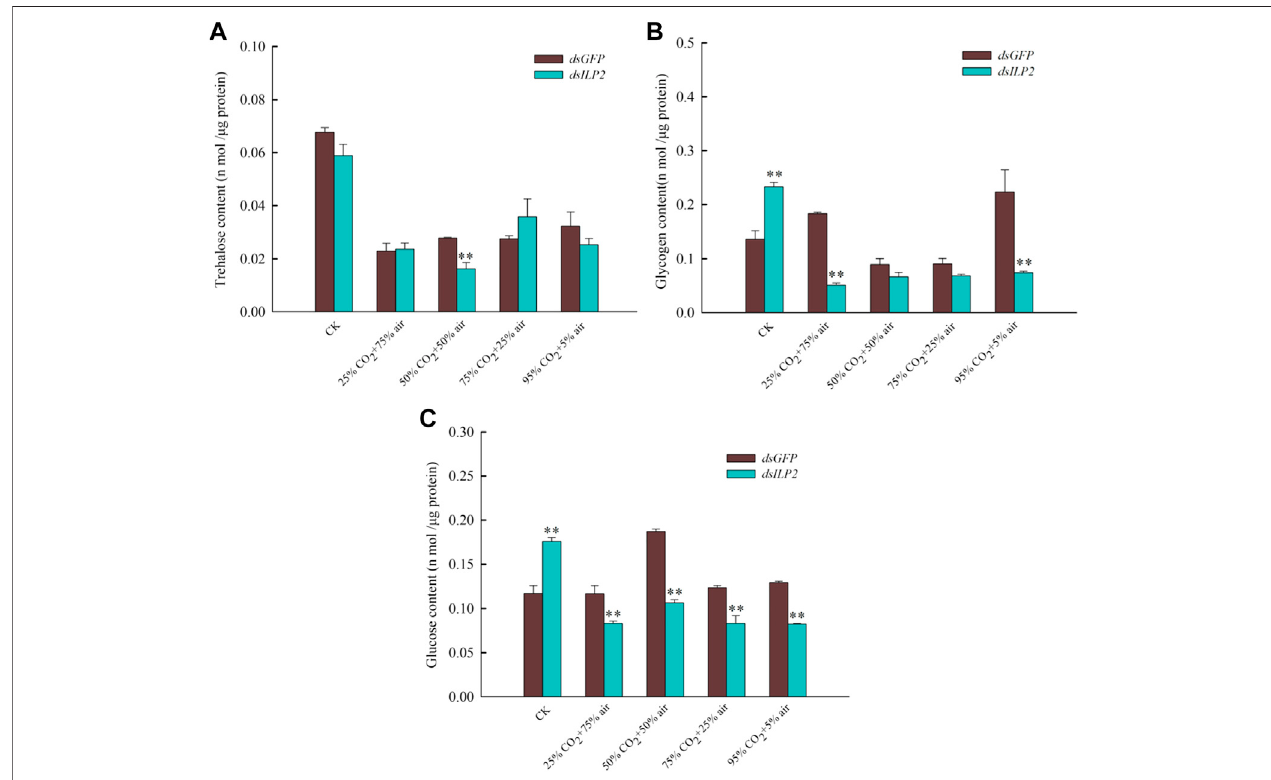
FIGURE 2 | Effects of TcILP2 knockdown on content of trehalose (A) , glycogen (B) , and glucose (C) . T. castaneum larvae were divided into three groups (each groupcovered 15larvae)andinjected withdsILP2 anddsGFPandcombinedwithtreatments of25%CO 2 +75%air,50%CO 2 +50%air,75%CO 2 +25%airand95% CO 2 + 5% air, respectively. Insects were collected and used to detect trehalose, glycogen, and glucose content after treatments for 48 h.